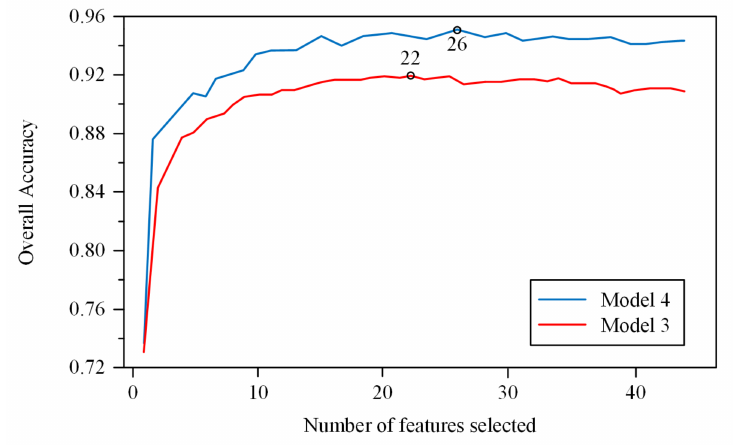
Figure 7. Variations in the overall accuracy with the number of features selected by the recursive feature elimination (RFE) based on the random forest (RF) algorithm in Model 3 and Model 4.